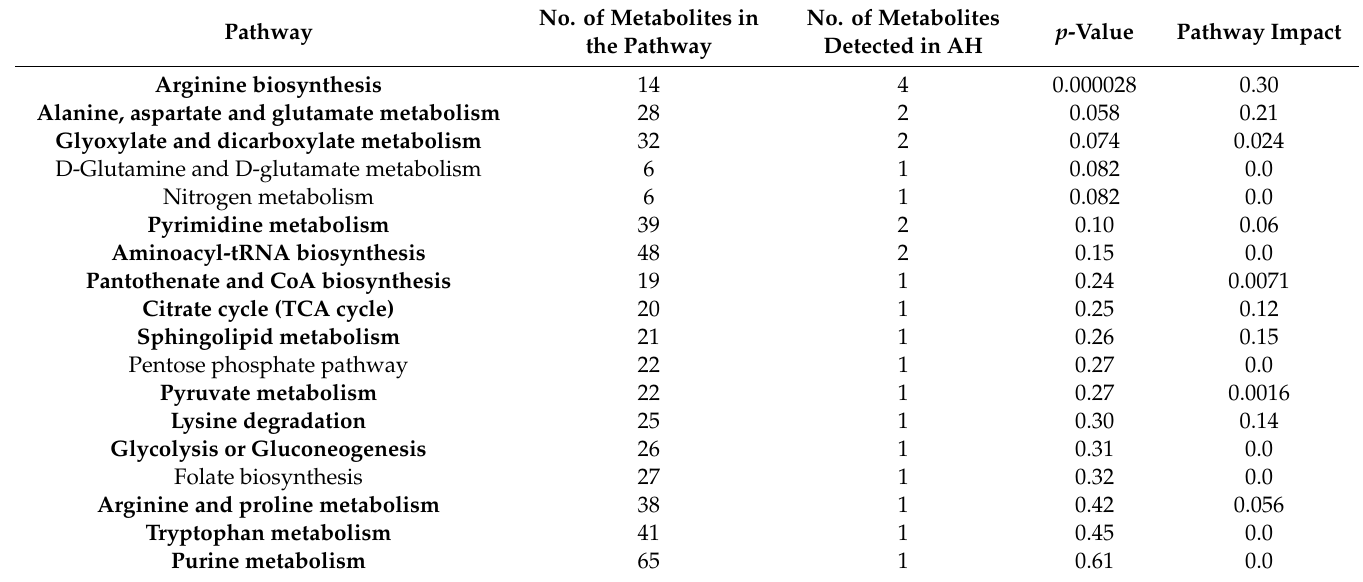
Table 4. Metabolic pathways corresponding to metabolites identified in AH